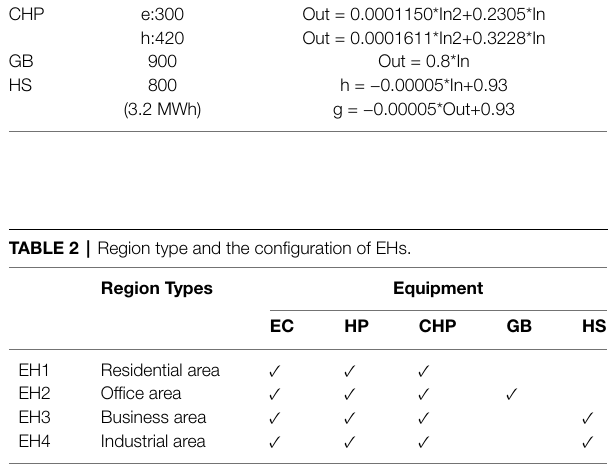
Frontiers in Energy Research |